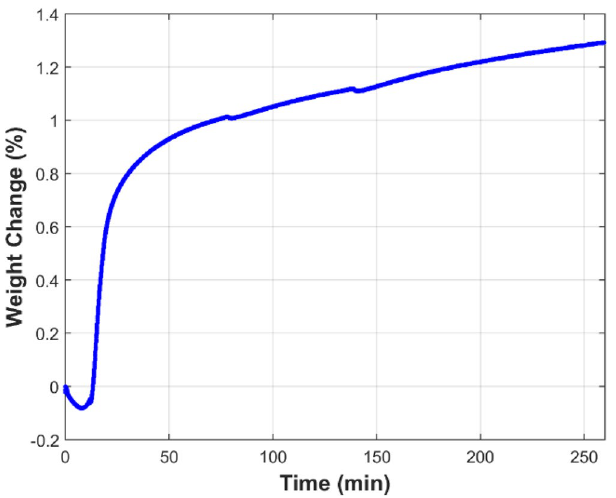
Figure 4. Percentage weight change of the FeCrAl fibers versus time during the first MSHT cycle.